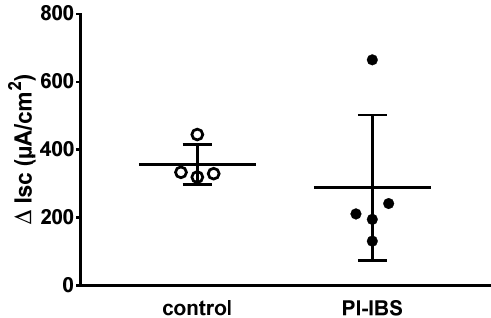
Figure 1. Electrogenic sodium transport measured in miniaturized Ussing chambers. Sodium transport J Na was determined after aldosterone stimulation as the decrease in short-circuit current Isc ( ∆ Isc) after adding amiloride, a selective ENaC channel blocker. ENaC-dependent electrogenic irritable bowel syndrome (PI-IBS) patients (no significant difference between the groups in Student’s t-test).